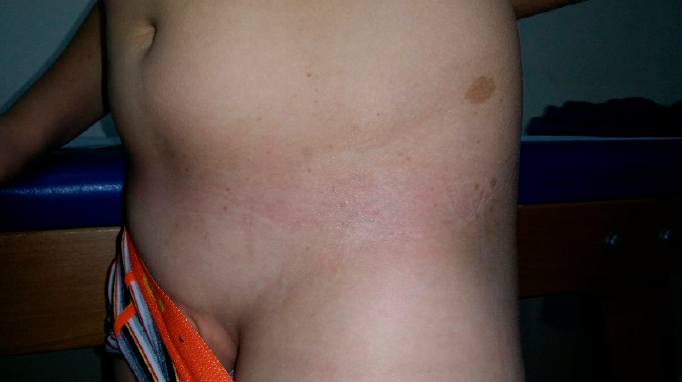
Figure 1. Segmental arrangement of CALMs and freckling in a patient with a mosaic form of